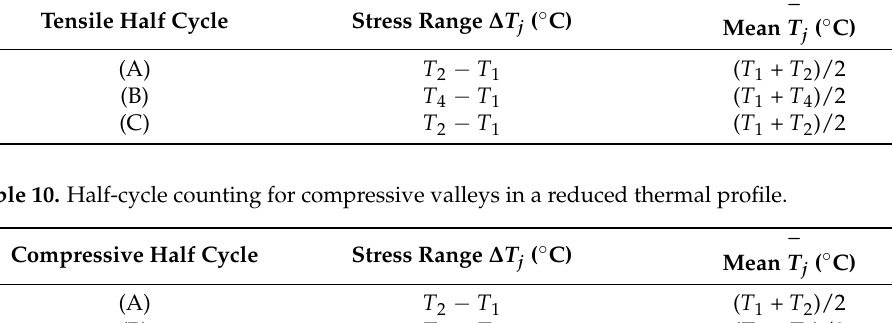
Table 10. Half-cycle counting for compressive valleys in a reduced thermal profile.